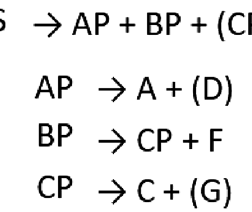
Figure 3. Rules of the artificial grammar (from Saffran 31 ). Letters A, C, D, F and G refer to categories, which each include a set of items (tones, syllables, or symbols in the different conditions). Items in each category were randomly distributed in sentences. A sentence consists of an “AP” phrase, a “BP” phrase, and an optional “CP” phrase. An “AP” phrase is made of an “A” category item and an optional “D” category item. A “CP” phrase consists of a “C” and an optional “G” item. A “BP” phrase is made of a “CP” phrase and an optional “F”